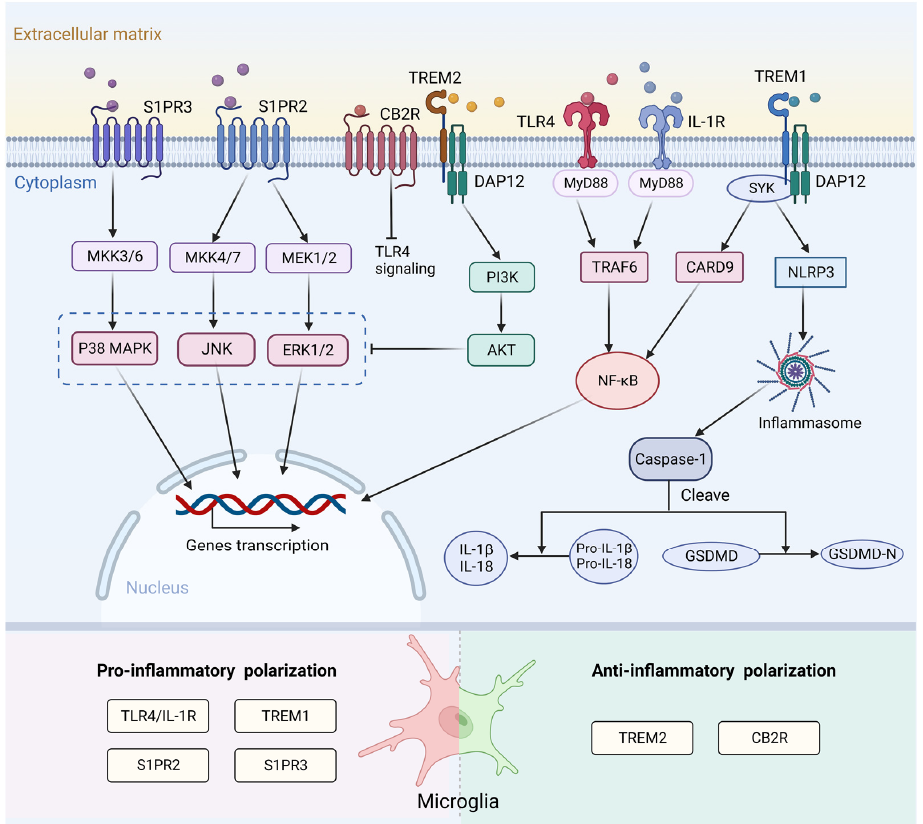
Figure 2. Surface receptors and the signaling pathways associated with microglia activation following stroke. After binding to endogenous ligand, TLR4 and IL-1R activate the MyD88/ NF- κ B pathway to increase the release of pro-inflammatory cytokines and induce a pro-inflammatory response. S1PR2 and S1PR3 affect microglial M1 polarization through the ERK1/2 and JNK pathways and p38 MAPK pathway, respectively. TREM1 can activate the downstream CARD9/NF- κ B and NLRP3/Caspase-1 signaling pathway to promote the release of inflammatory factors. TREM2- DAP12 interaction activates the PI3K/AKT signaling pathway, which can inhibit TLR4 signaling by blocking MAPK cascade. CB2R exerts anti-inflammatory effects after stroke. This mechanism may be related to inhibition of the TLR4/NF- κ B signaling pathway. TLR4, toll-like receptor 4; IL-1R, interleukin-1 receptor; MyD88, myeloid differentiation factor 88; NF- κ B, nuclear factor kappa-B; S1PR2, sphingosine-1-phosphate receptor 2; S1PR3, sphingosine-1-phosphate receptor 3; ERK1/2, extracellular signal-regulated kinases 1/2; JNK, c-Jun N-terminal kinase; p38 MAPK, p38 mitogen- activated protein kinase; TREM1, triggering receptor expressed on myeloid cells 1; CARD9, caspase recruitment domain family member 9; NLRP3, NOD-like receptor thermal protein domain associated protein 3; TREM2, triggering receptor expressed on myeloid cells 2; DAP12, DNAX activation protein 12; PI3K, phosphatidylinositol 3-kinase; AKT, protein kinase B; MAPK, mitogen-activated protein kinase; MKK3/6, mitogen-activated protein kinase kinase 3/6; MKK4/7, mitogen-activated protein kinase kinase 4/7; MEK1/2, mitogen-activated protein kinase kinase 1/2; SYK, spleen tyrosine kinase; TRAF6, tumor necrosis factor receptor-associated factor 6; IL-1 β , interleukin-1 β ; IL-18, interleukin-18; GSDMD, Gasdermin D. Created with BioRender.com Sphingosine-1-phosphate (S1P) is an important bioactive lysophosphatidylcholine. It regulates various biological functions through its five specific G protein-coupled receptors (S1PR1-5) [124,125], which are broadly expressed in microglia [126]. S1P transporters are involved in pro-inflammatory microglial activation [127]. In an ischemia rat model, the addition of S1P to primary microglia increased the level of cytokine IL-17 [128]. S1P re- ceptor 2 (S1PR2) affects M1 polarization through extracellular signal-regulated kinases (ERK)1/2 and c-Jun N-terminal kinase (JNK) pathways in ischemic stroke. Inhibition of